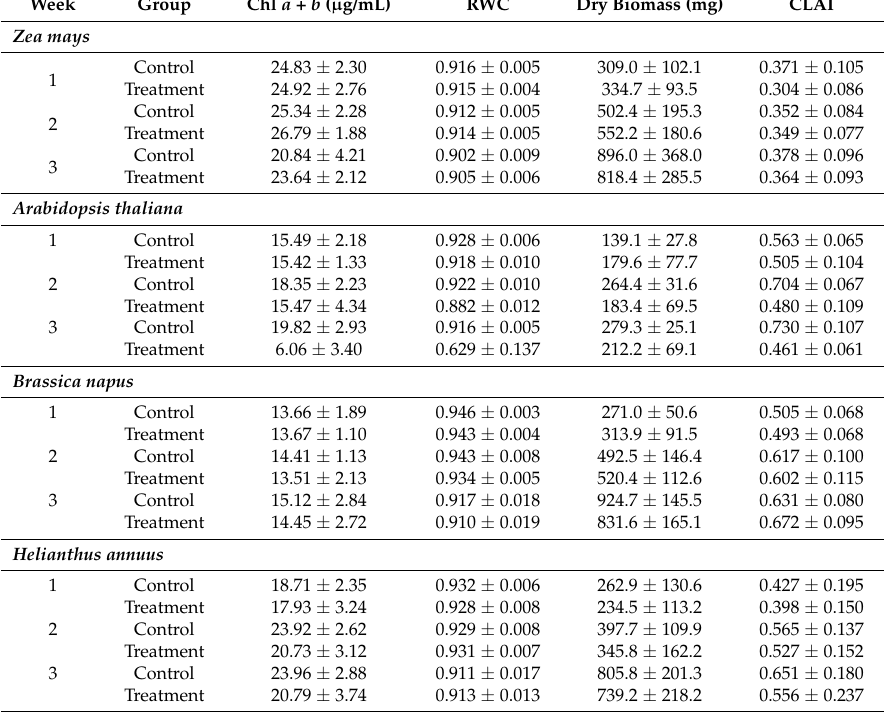
Table A1. Summary statistics for sample endpoints by week and treatment group. Cells contain the mean ± the standard deviation of the mean. For each cell n = 12, except dry biomass for A. thaliana for which n = 6 for each cell, and Chl a + b for A. thaliana in Week 3 for which n = 11 (insufficient plant material available for one sample).